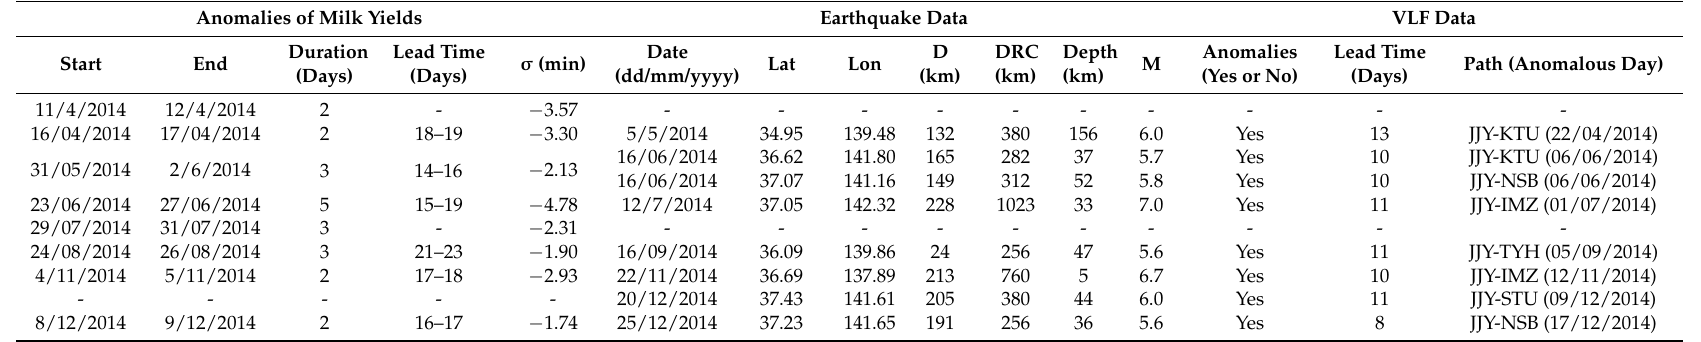
Table 6. The correspondence table of the anomalous milk yields, the observed targeted earthquakes and VLF data. Lat = Latitude, Lon = Longitude, D = Distance from epicenters, DRC = Dobrovolsky radius